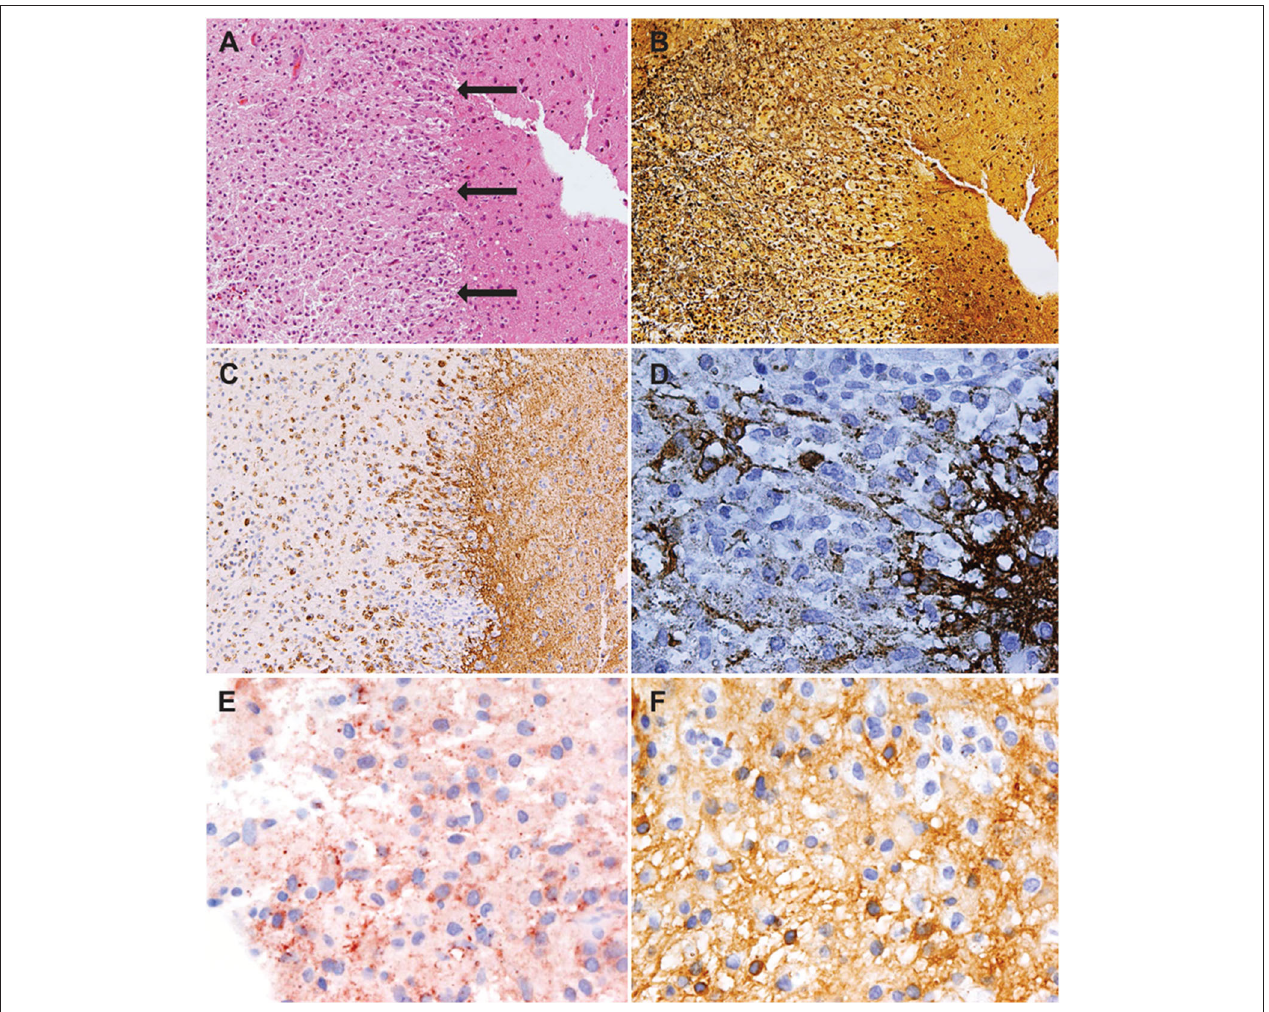
FIGURE 2 | Histology showed an active demyelinating multiple sclerosis (MS) lesion corresponding to immunopathological pattern II. Arrows indicate the sharply demarcated inflammatory subcortical plaque on the left; the cerebral cortex is present on the right [H&E stain, × 10 (A) ]. Axons were preserved within the lesion [Bielschowsky silver stain, × 10 (B) ], whereas myelin was lost [proteolipid protein, × 10 (C) ; cyclic nucleotide phosphodiesterase stain, × 40 (D) ]. The lesion showed early active demyelination as indicated by the presence of major (C) and minor myelin proteins (D) within the macrophages. Complement [c9neo complement stain, × 40 (E) ] and immunoglobulin G [IgG; IgG stain × 40 (F) ] were found within the macrophages, suggesting a complement and immunoglobulin-mediated demyelination (pattern